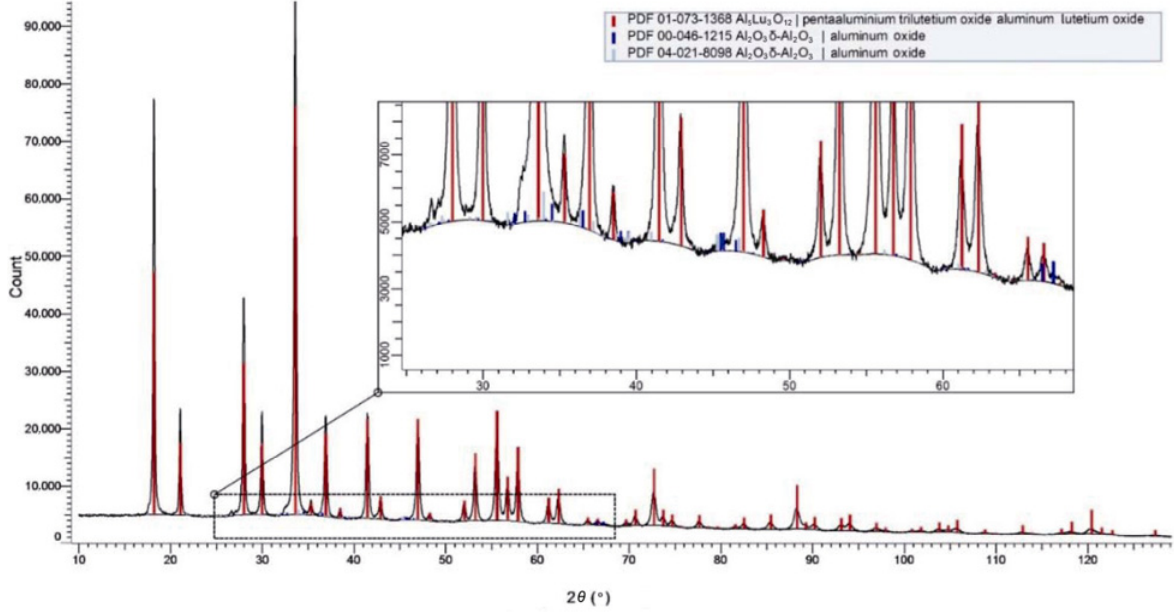
Fig. 2 XRPD pattern of LuAG–Al 2 O 3 nanoceramics crystallized from ALu28 glass-based precursor via a 2-h heat treatment at 1100 ℃ in